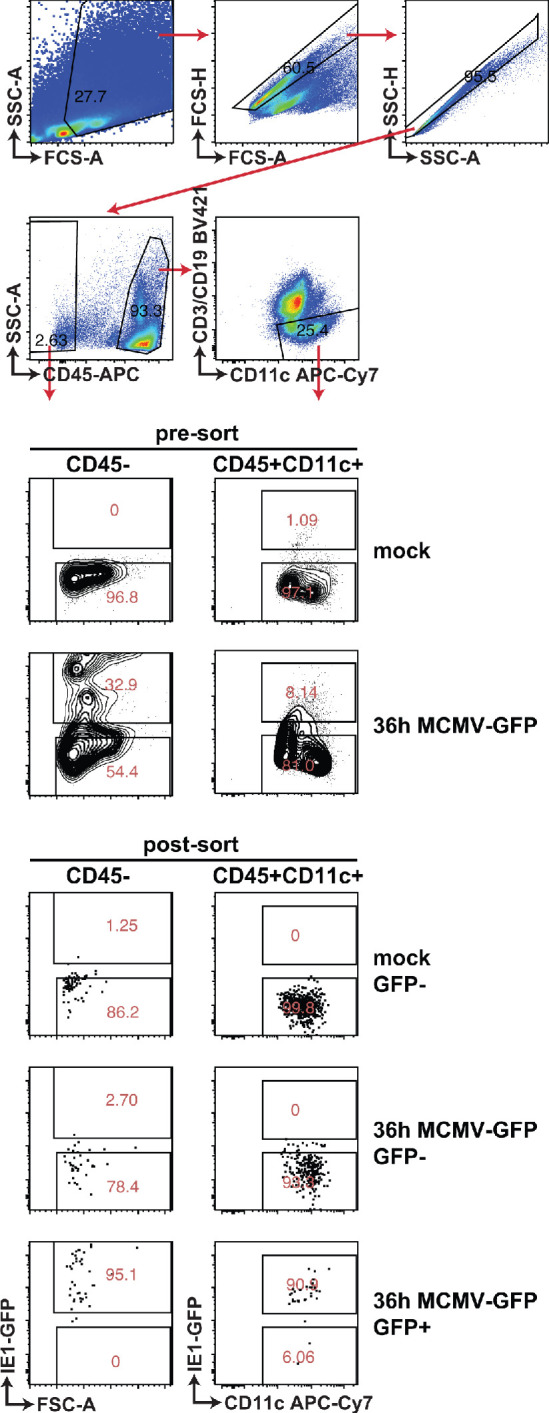
Gating strategy and purity of sorted cell populations.WT mice were infected with 100,000 PFU MCMV IE1-GFP reporter virus. GFP+ and GFP- stromal cells and DC were FACS-sorted 36 hours p.i. Representative gating strategy and purity of sorted cells that were used in Figure 3BC are shown.